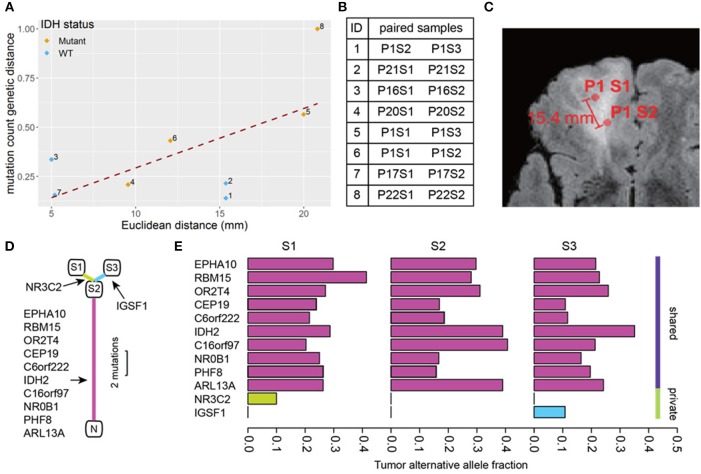
Mutation count genetic distance. (A) Scatter plot shows a high correlation between Euclidean distance and the Jaccard distance between biopsy pairs (Pearson r = 0.63). (B) The pairs of biopsy points whose distances are graphed in (A). The samples are listed by patient number (P) and sample number (S) so for example pair 1 consists of sample 2 from patient 1 (P1S2) and sample 3 from patient 1 (P1S3). (C) Physical distance illustration. On this magnetic resonance image, a biopsy pair in patient 1 (samples P1S1, P1S2) are indicated by circles. The Euclidean distance between the sample sites is shown. (D) The phylogenetic tree of three biopsies from the same patient (P1). N represents normal brain (no mutations), and S1-3 are the three biopsy sites sampled. The detected mutations events are shown in the annotations, the segment length is proportional to the number of mutations. (E) The tumor alternative allele fraction for all mutation events were compared between biopsies shown in (D). The shared mutations between all samples generally show a higher alternative allele frequency.